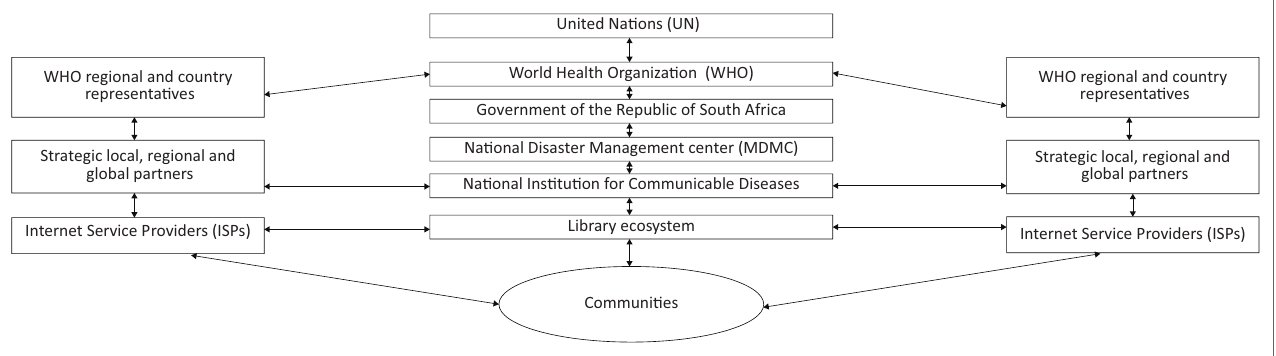
FIGURE 1: Collaborative framework for libraries in times of emergency (COVID-19